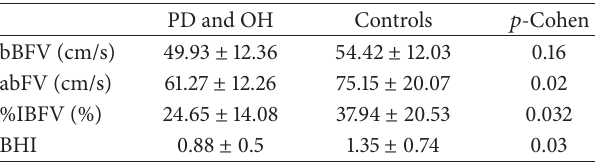
Table 4: Cerebral hemodynamic data for PD patients with OH and controls.